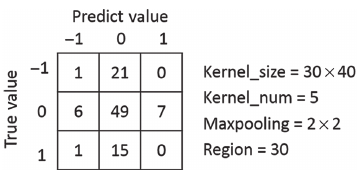
Figure 13: Confusion Matrix of Experiment 3 in Architecture